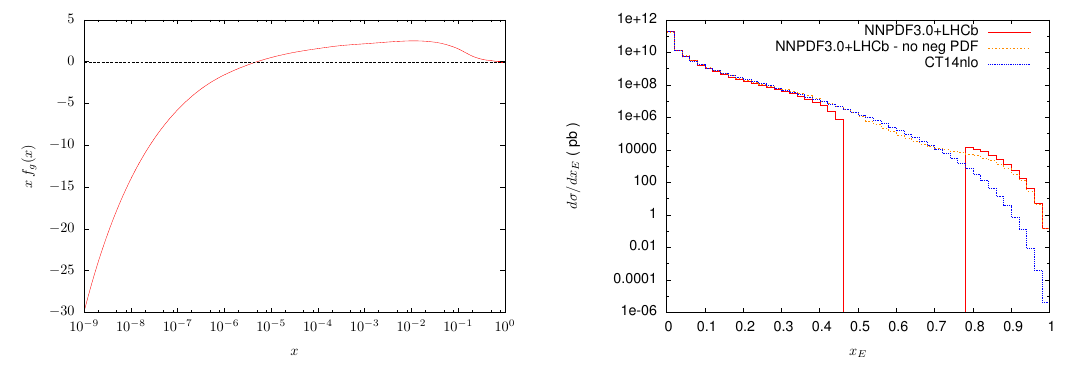
Figure 20 . Left: gluon distribution according to the latest version of the NNPDF3.0 + LHCb PDF set at (cid:22) f = 1 : 5 GeV. Right: di(cid:11)erential cross sections d (cid:27) /d x E of inclusive D 0 hadroproduction, pp D 0 + X , for initial-state protons with a laboratory energy E p; lab = 10 8 GeV. The orange ! graph is generated by setting the NNPDF3.0 + LHCb PDFs to zero when they are negative.